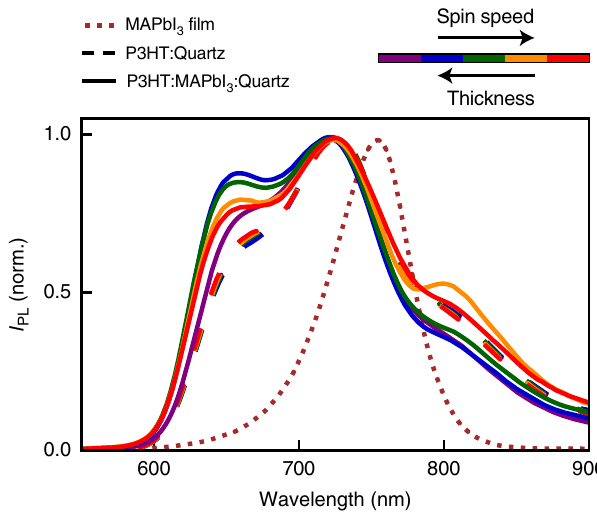
Fig. 4 Changes in PL spectral shape when P3HT fi lms of different thicknesses are deposited on MAPbI 3 or quartz. Normalised PL intensity from P3HT fi lms deposited through spin coating from solution with varying spin speeds onto either quartz (dashed lines) or MAPbI 3 :quartz (solid lines) substrates. The line colours indicate spin speeds that anti-correlate with the P3HT fi lm thicknesses achieved. Spin speed was increased from 2000 to 6000 rpm in steps of 1000 rpm, yielding P3HT fi lm thicknesses from 92 to 40 nm for the fi lms on MAPbI 3 :quartz and 77 to 42 nm for the P3HT fi lms on quartz ( fi lm thickness does not scale linearly with spin speed; the full list of values is provided in Supplementary Table 3). In addition, the normalised PL spectrum of a MAPbI 3 fi lm on quartz is shown as a dotted brown